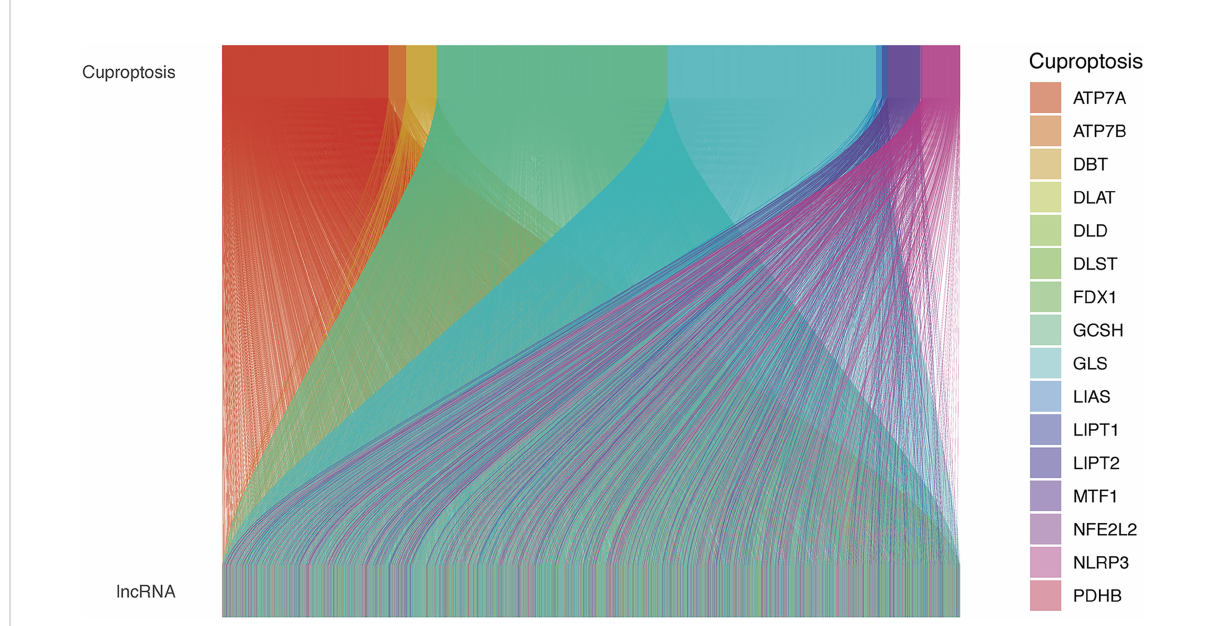
FIGURE 1 The relationships between cuproptosis-related genes and cuproptosis-related lncRNAs in the Sankey diagram. lncRNA, long noncoding RNA.